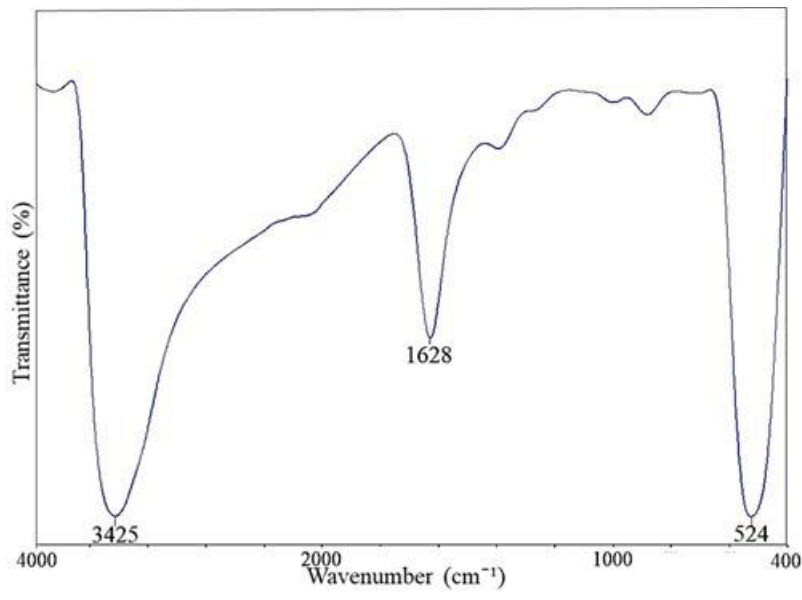
Figure 3. FTIR Spectrum of ZnO NPs.